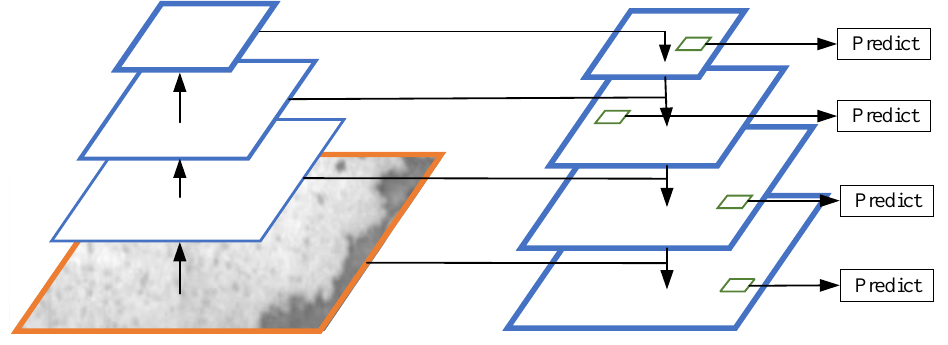
Figure 7. Improved feature fusion network .